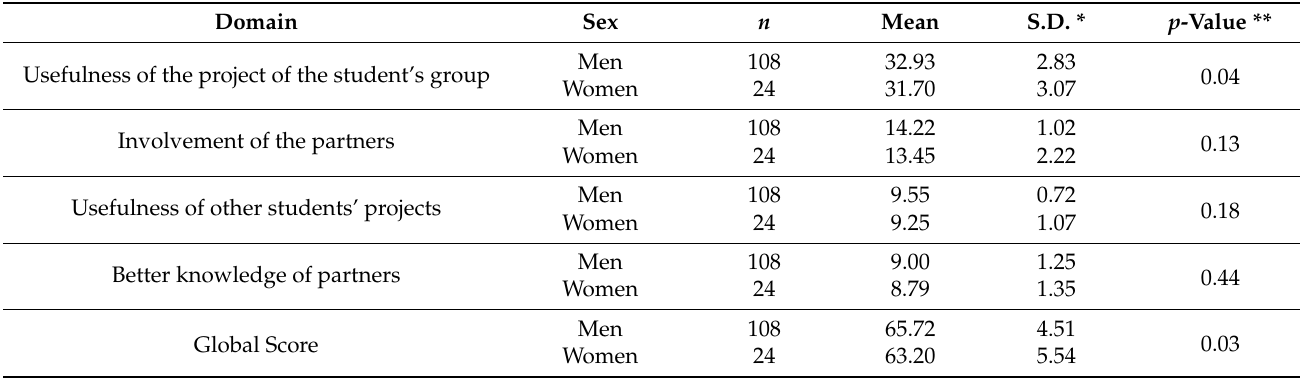
Table 9. Score of the domains, regarding sex.